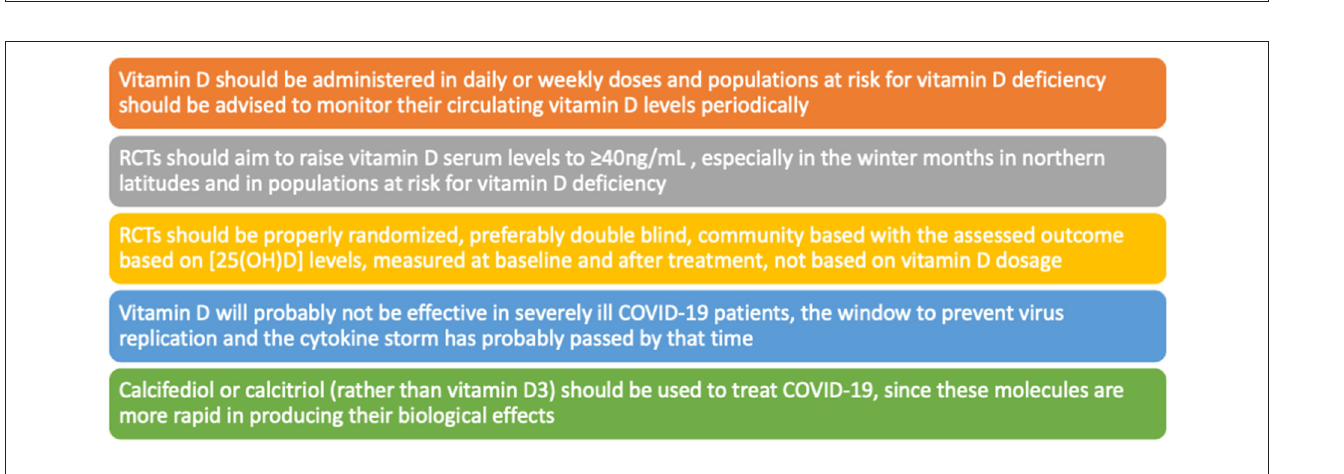
FIGURE 4 | Authors recommendations regarding vitamin D research and